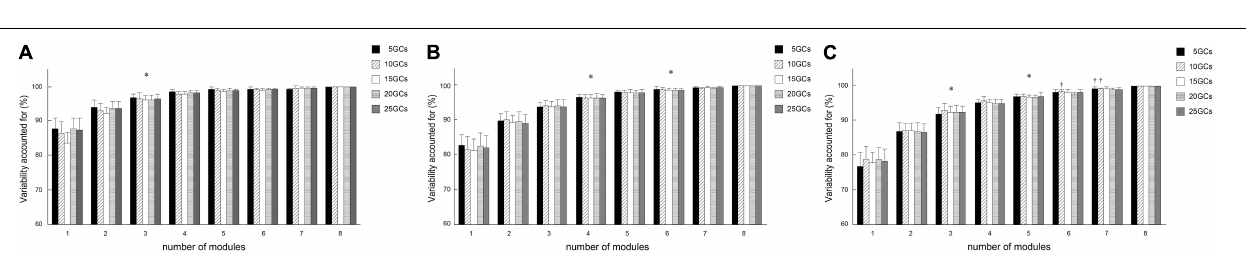
Frontiers in Human Neuroscience |